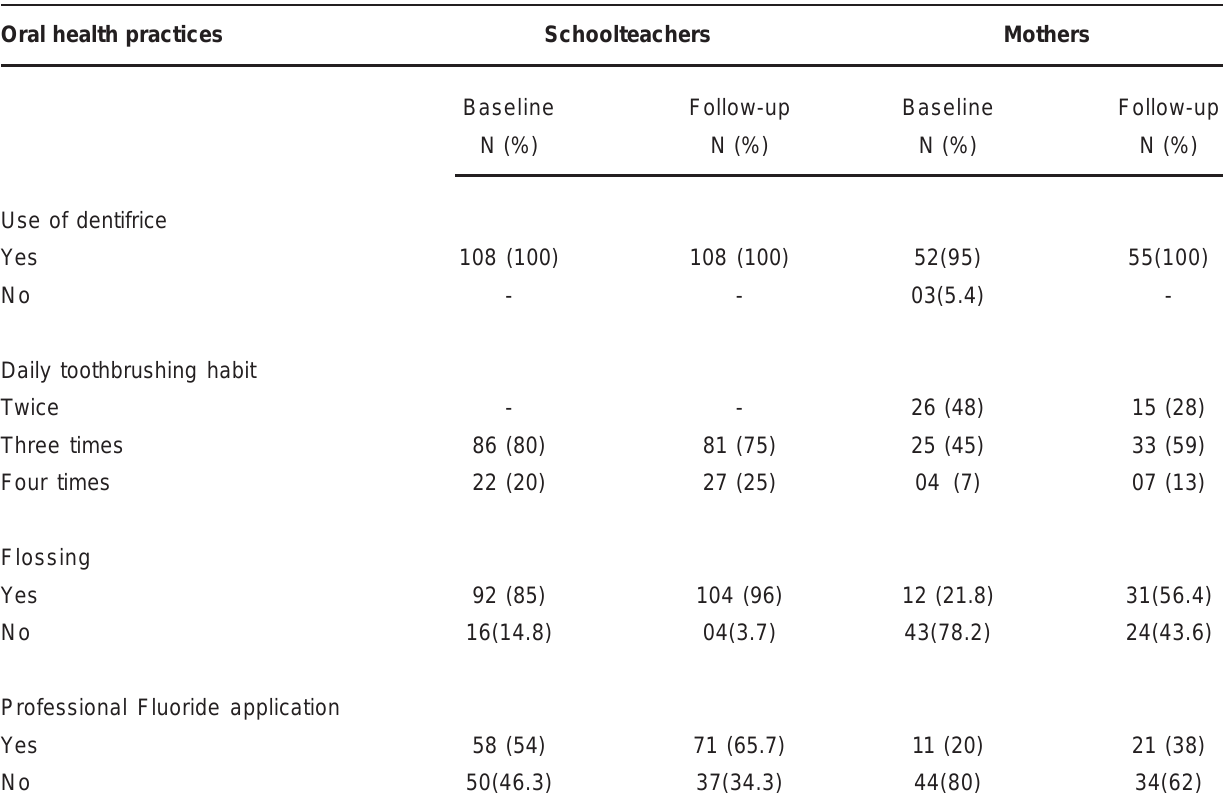
TABLE 3 - Oral health practices among schoolteachers (N=108) and mothers (N=55) of the schoolchildren of public schools in Maringa, Brazil, at baseline and at follow-up interviews